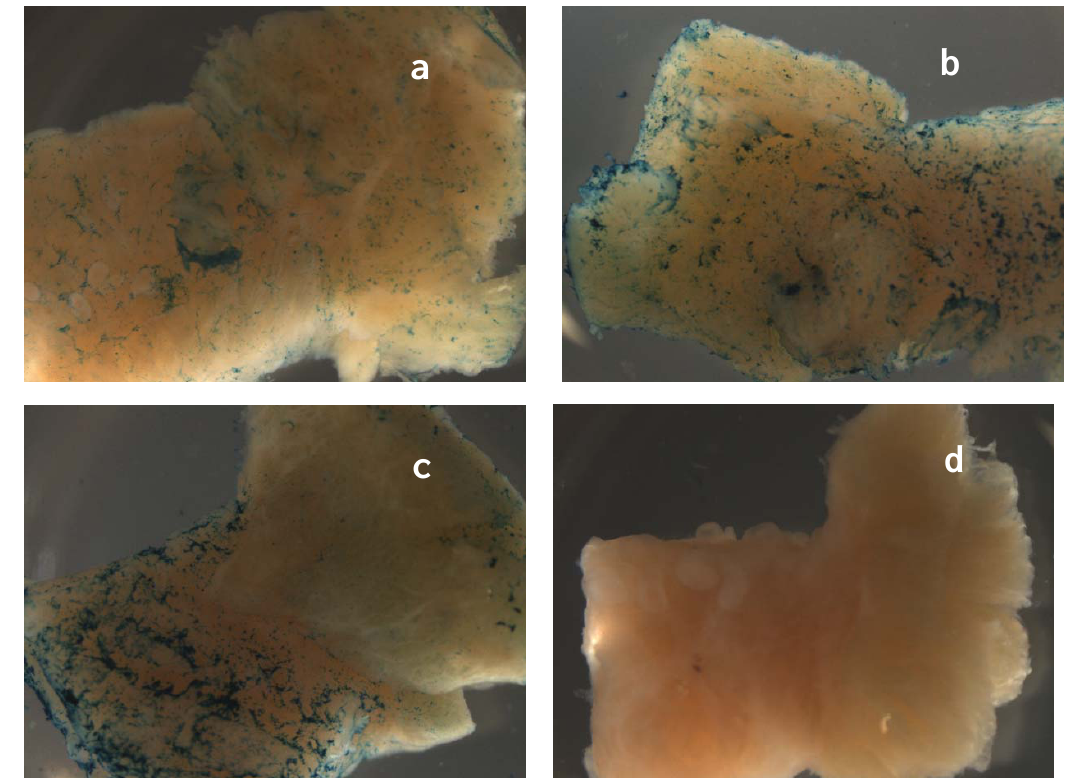
Figure 2. Macrophotographs (at 7.5x magnification) of tissue samples exposed to uncomplexed ABG (a), {bTAT+ABG} (b) and {bTP+ABG} (c) in the experiment abbreviated as “ACE_1” (see Table 1 for details). The tissue samples were from the specimen diagnosed with stage IA adenocarcinoma of the endometrium (ACE). The myometrial parts of samples are directed to the left. The image of the negative control (“no drug”) is in panel